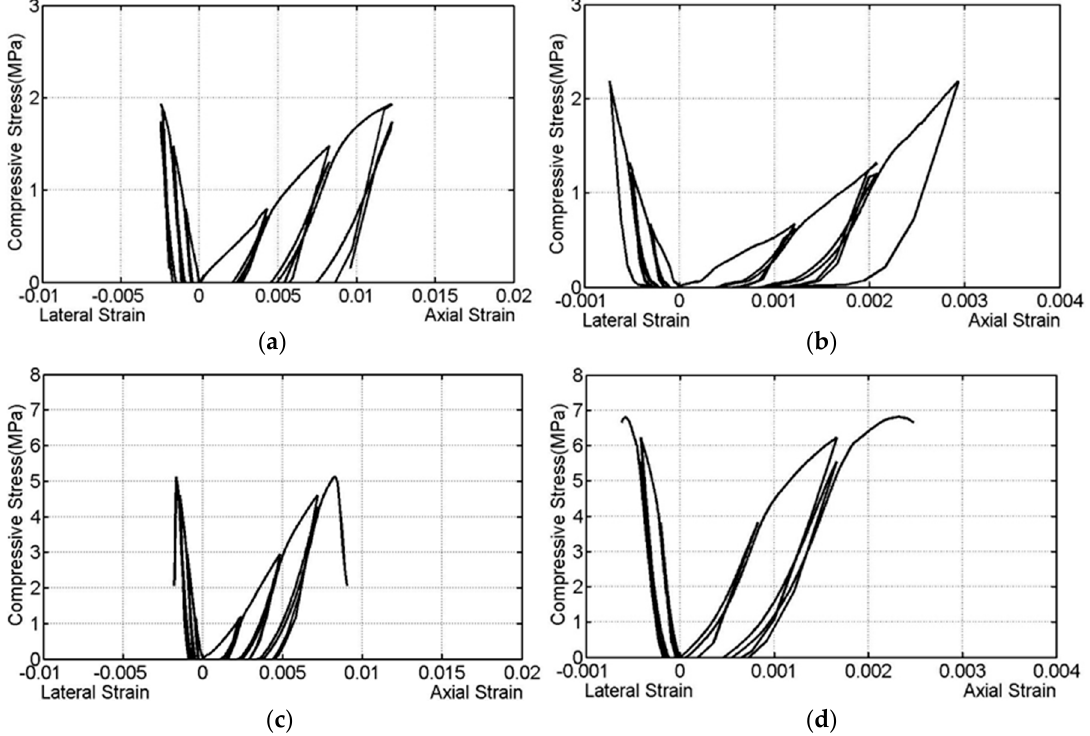
Figure 4. Cyclic compressive stress–strain curves of the wallettes under compression ( a ) CB1-NHL, ( b ) CB1-CM, ( c ) CB2-NHL, and ( d ) CB2-CM. Table 7. Cyclic compressive strength and deformation properties.